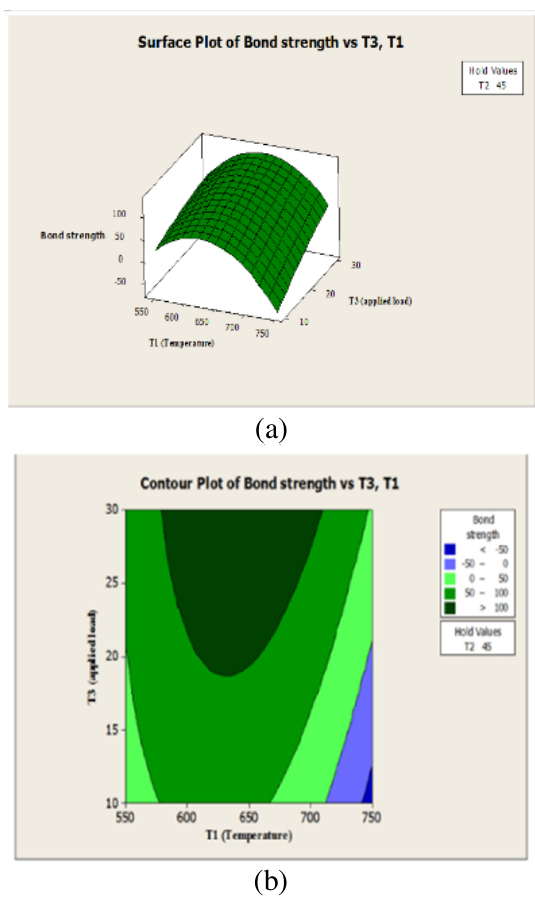
Fig. 6. Effects of temperature and applied stress on bond strength (a) 3D surface plot (b) 2D contour plot.